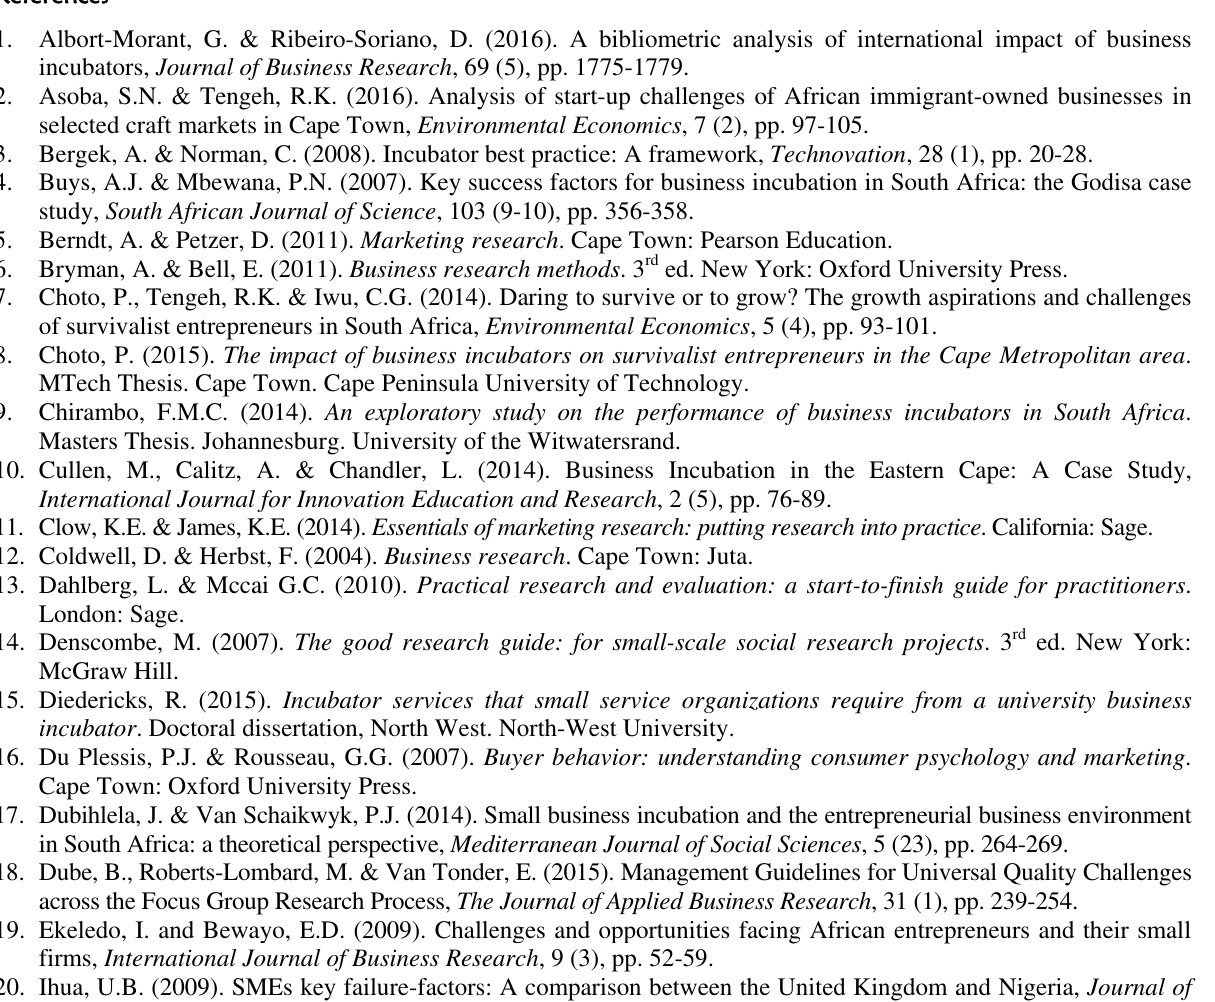
Table 11 dealt with how the lack of access to external market impacted on growth, required respondents to indicate the degree to which they agreed to a related statement. A total of 44 (47%) of the incubatees agreed that lack of access to external market affect their business growth, while 21 (23%) strongly agree that lack of access to external market was a challenge to growth. These results are in line with the results of Masutha and Rogerson (2014) who noted that business incubatees have only 7% access to the (international) markets, whereas local markets accounted for 93%. This shows that incubatees have limited chances of expanding their market